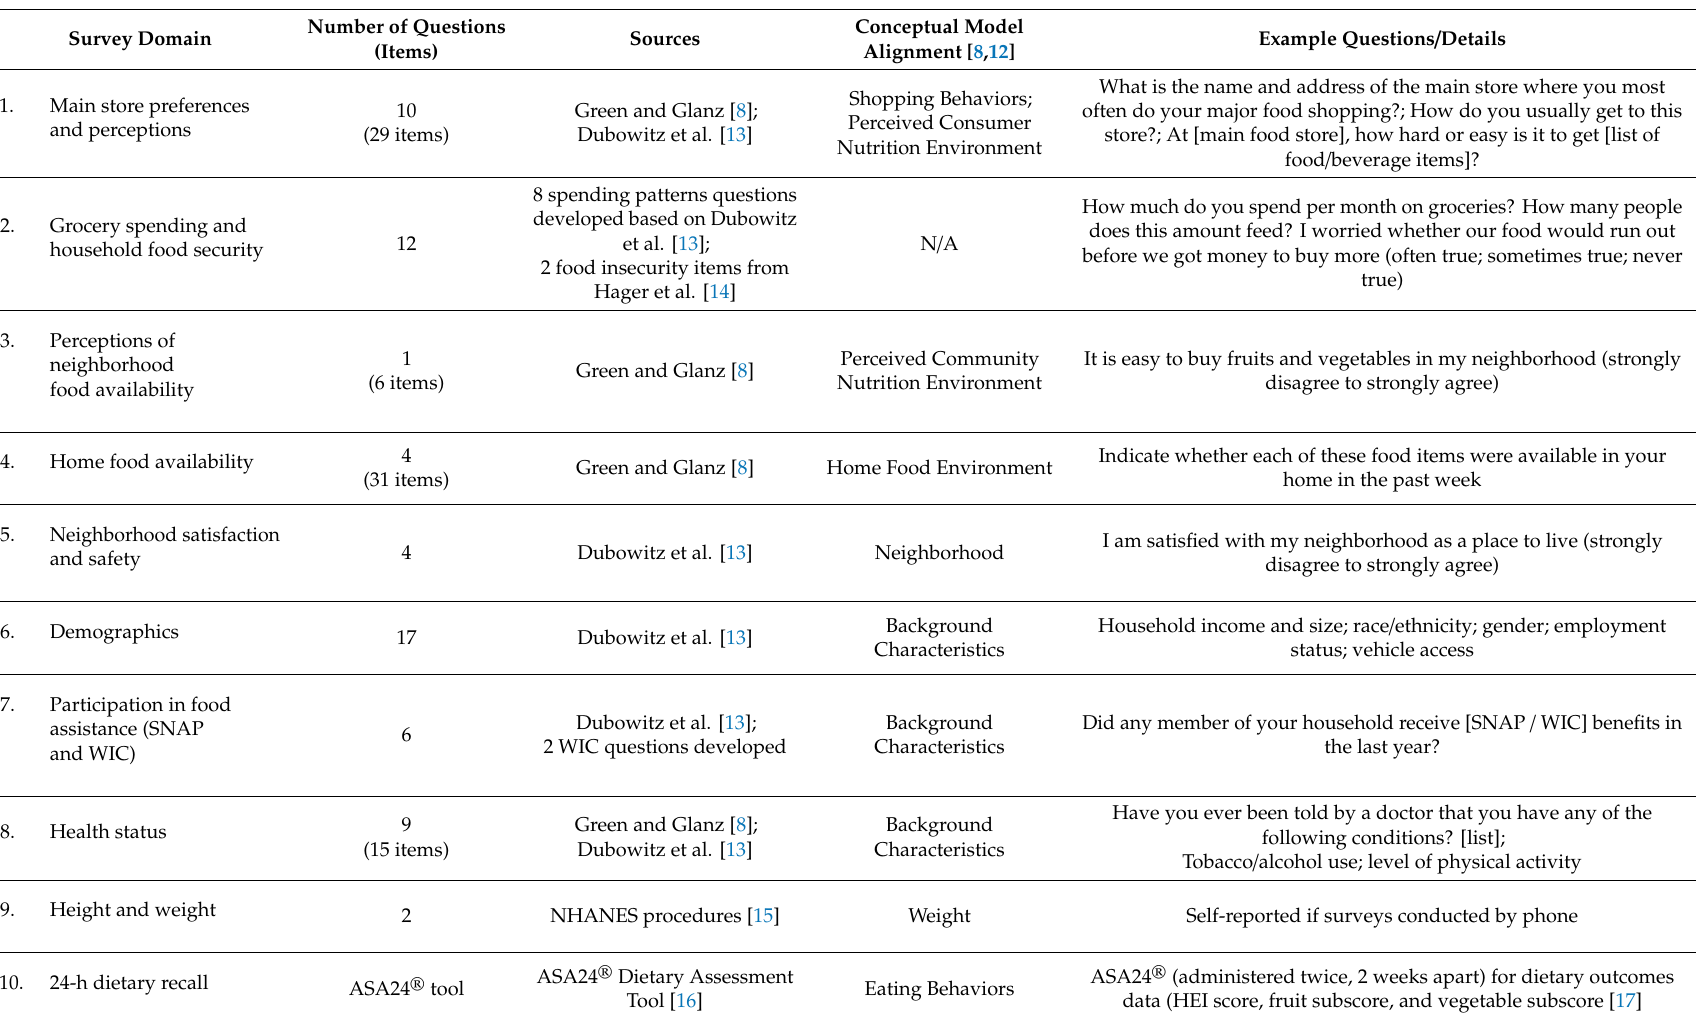
Table 1. Participant Survey Domains, Sources, and Alignment with Conceptual Models of the Nutrition